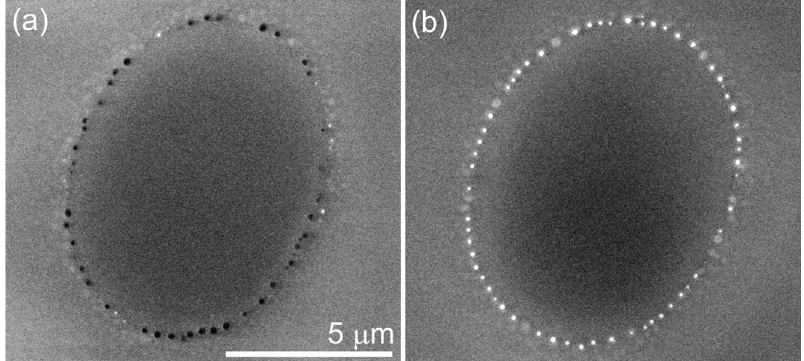
Figure 15. Secondary electron (SE) images of the front side of laser-annealed areas produced in ( a ) air and ( b ) O 2 atmospheres during 1-s exposure. Surface features are white, holes are black. The scale is the same in both panels. Figure courtesy of Marianna